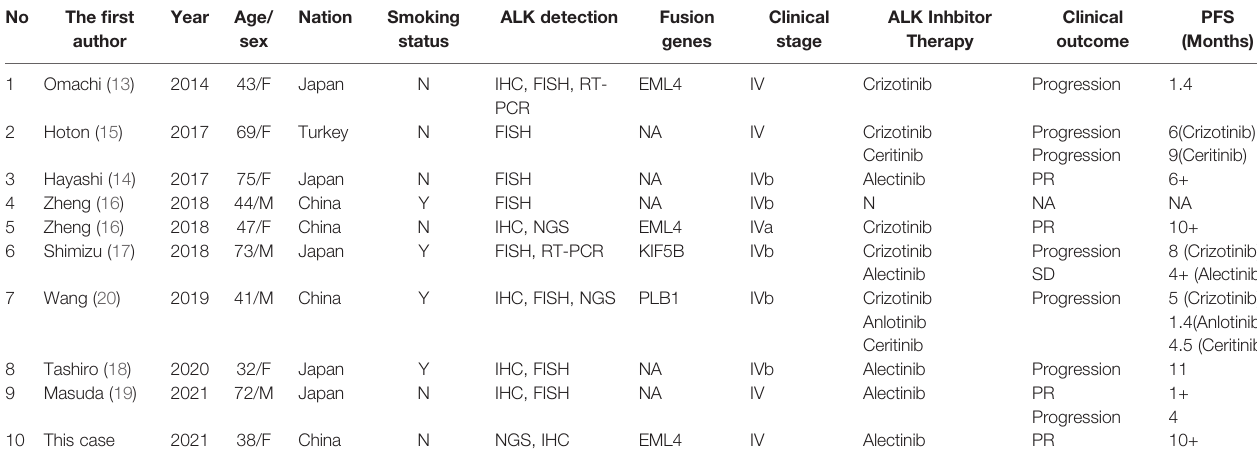
TABLE 1 | List of cases reported to have lung LCNEC with ALK rearrangement.